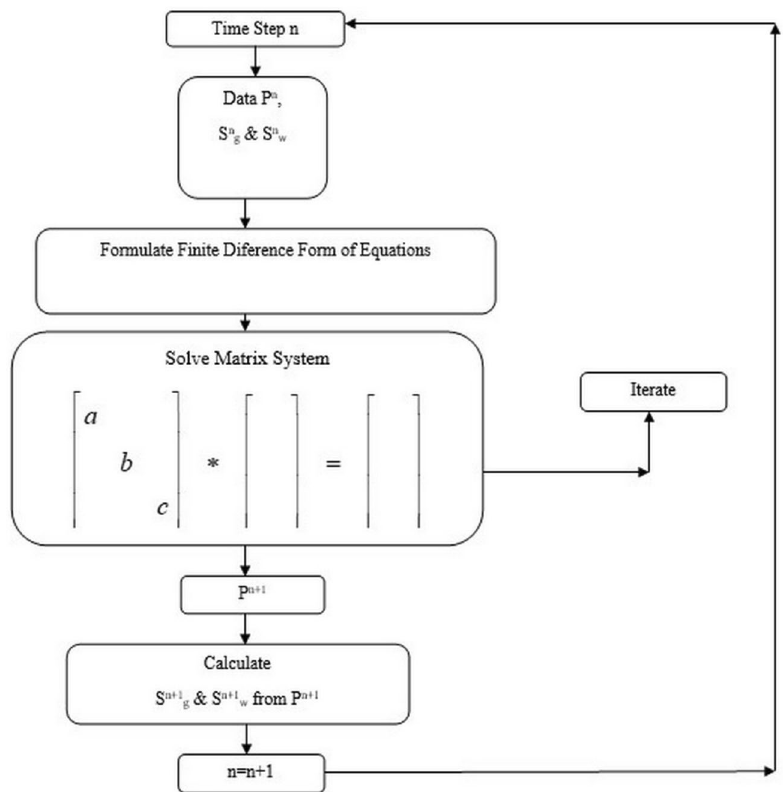
Fig. 4 IMPES method solution